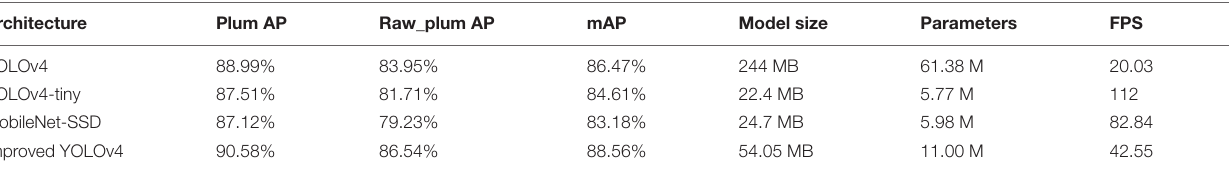
FIGURE 6 | The comparison of detection effect of plum images before and after improved data balance. TABLE 3 | Comparison of detection results of different architectures.